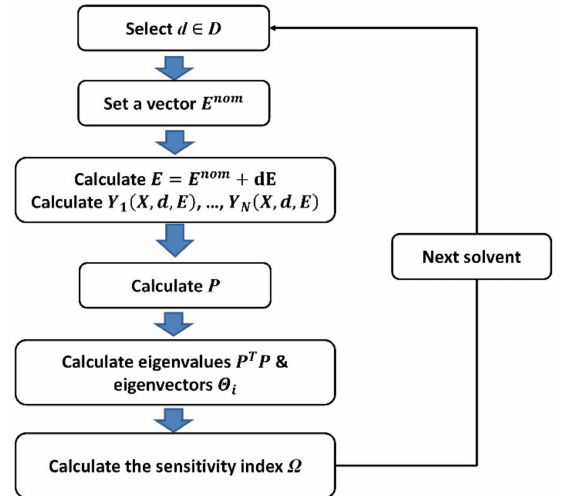
Figure 1. Logical diagram of the sensitivity analysis approach used for the process operability